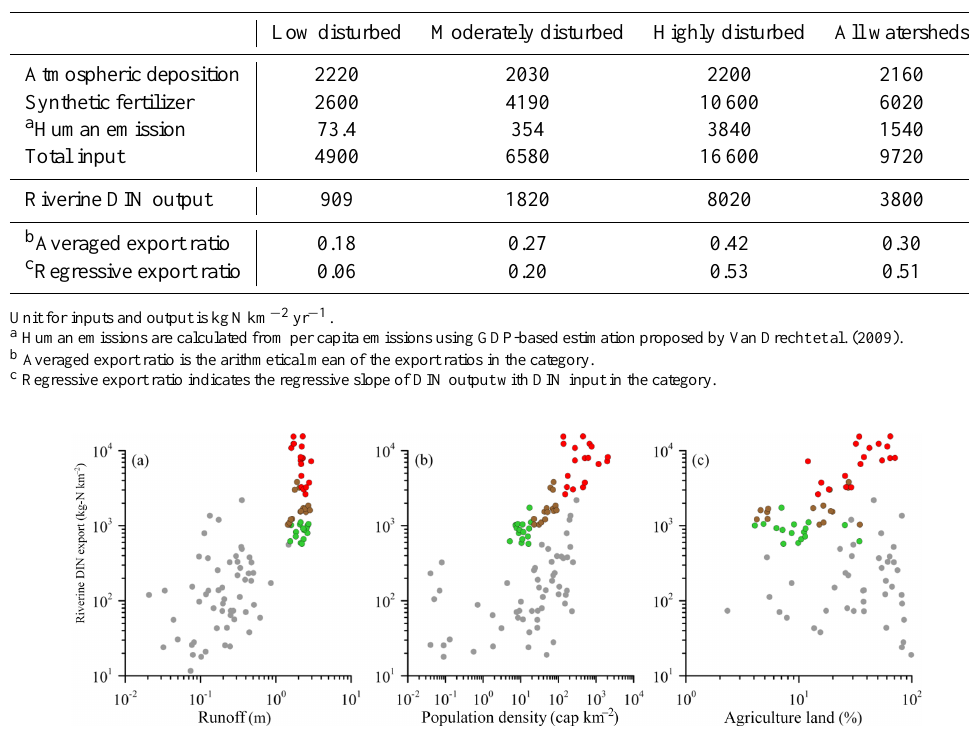
Figure 5. Scatterplot of riverine DIN export associated with runoff (a) , population density (b) , and relative agricultural land cover (c) . The gray dots represent the global river data retrieved from He et al. (2011). The green, brown, and red dots show the low, moderately, and highly disturbed watersheds, respectively.